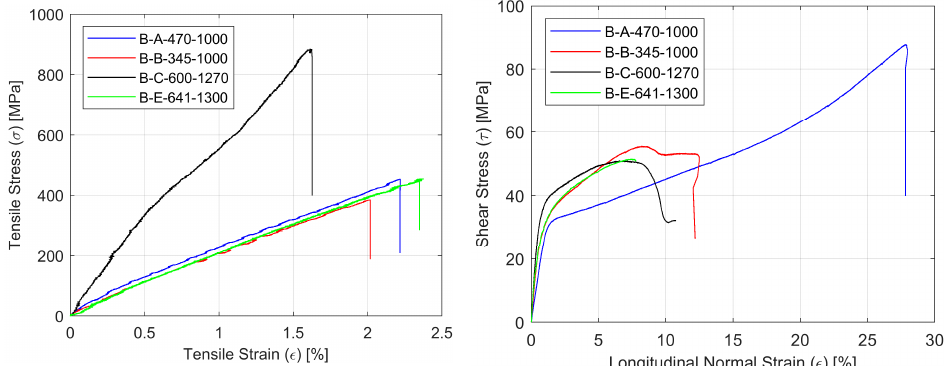
Figure 3. Representative curves for composite specimens with four types of reinforcement for tensile tests σ - ε ( left ) and the shear by tensile test τ - ε ( right ).